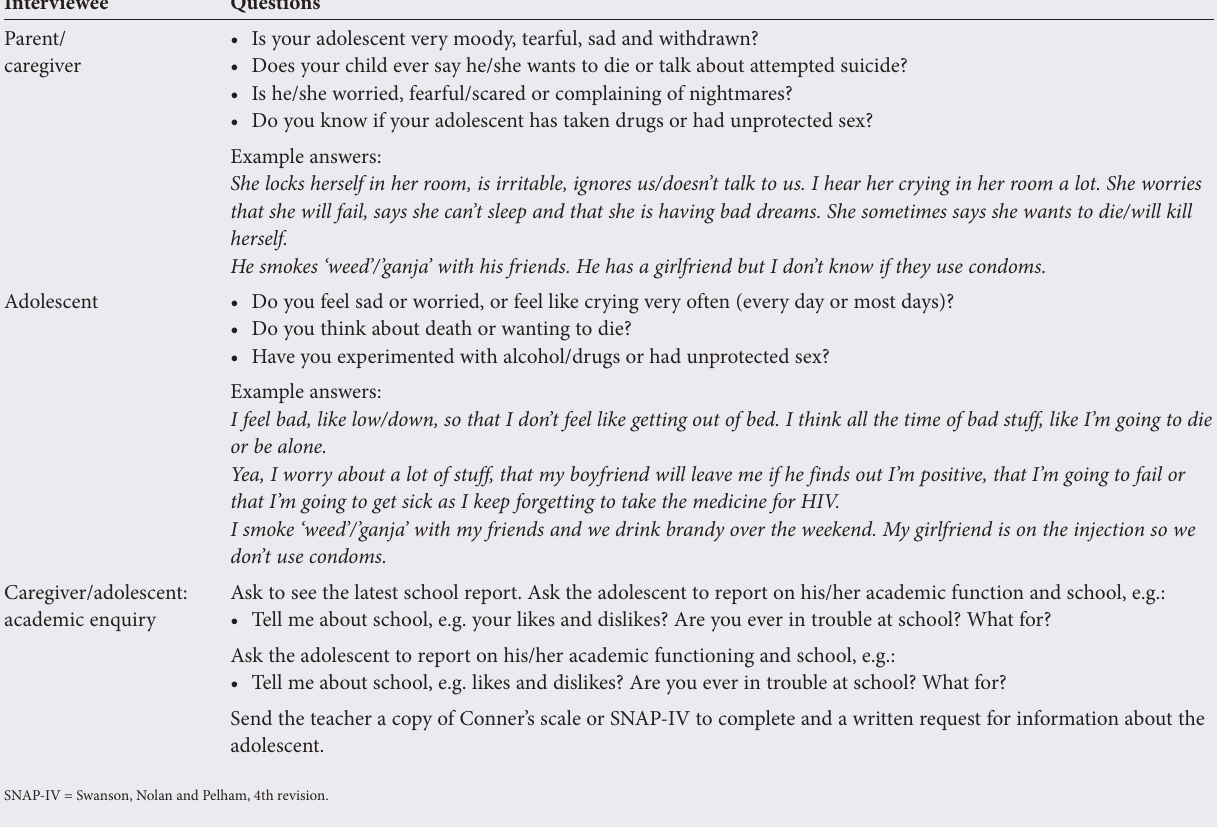
Table 3. Detecting commonly occurring mental disorders among HIV-infected adolescents Interviewee